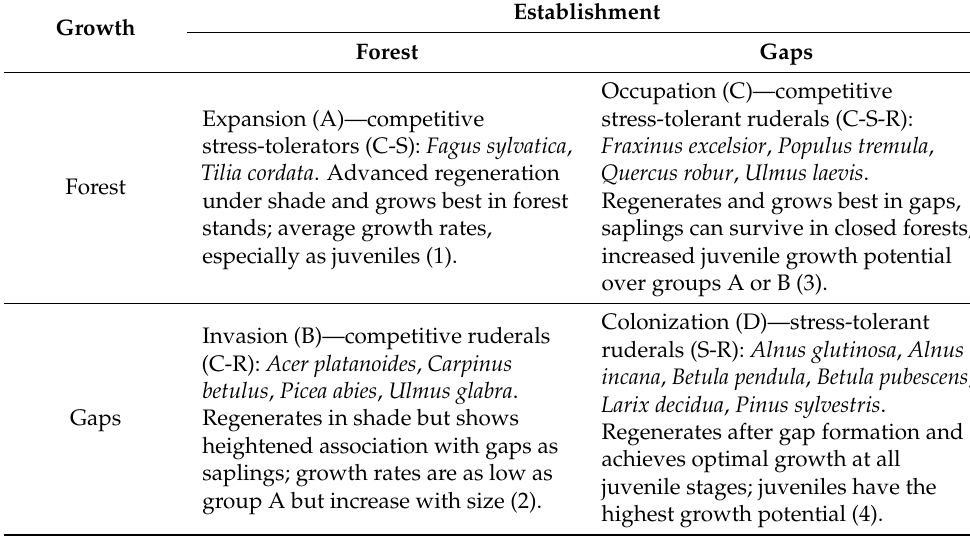
Table 2. Tree regeneration strategies: the four types of tree natural establishment and growth in forest gaps [114,124,126] resemble Clark and Clark’s [127] tree species regeneration groups (A–D), Grime’s [128] four main types of secondary strategies in plants (S-R, C-S-R, C-R, and C-S), and Whitmore’s [129] tree species groups (1–4), having increasing “pioneer index”. Modified from Franklin